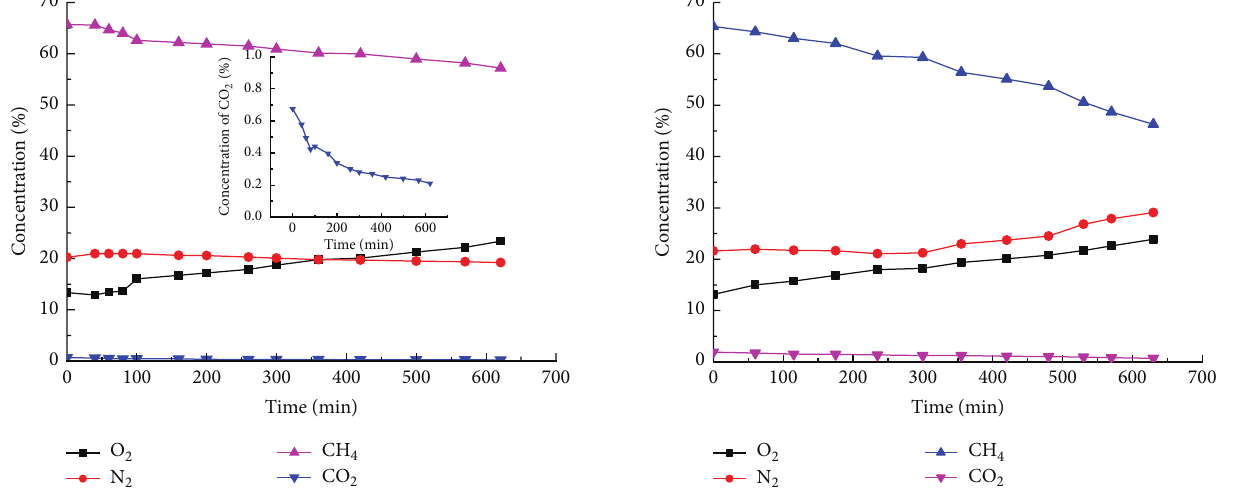
Figure 3: Gas concentration of hydrate formation in SDS solution.